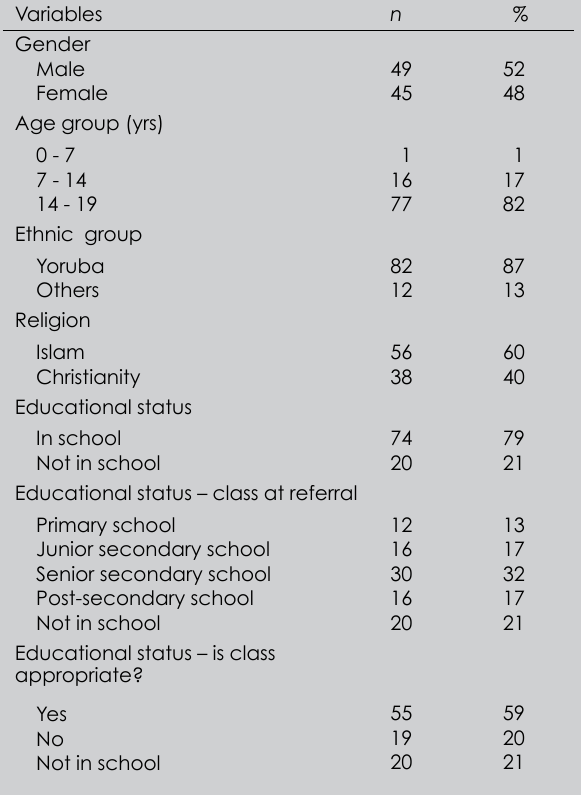
Table II. Family characteristics of the children and adolescents ( N